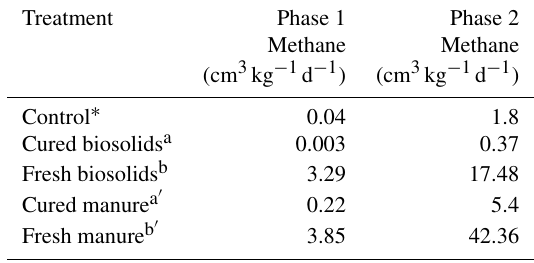
Table 3. Experiment 2a. Methane gas data for incubations with fresh and cured organic matter in sandy loam soil.